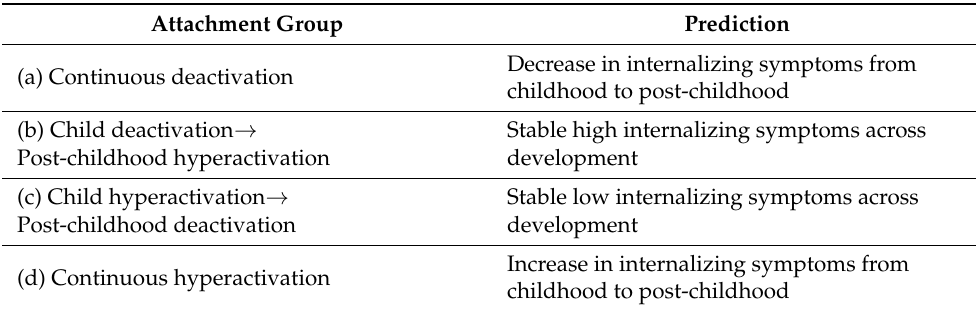
Table 3. Predictions of the mis/match hypothesis in the context of insecure attachment patterns and internalizing symptoms across the lifespan per